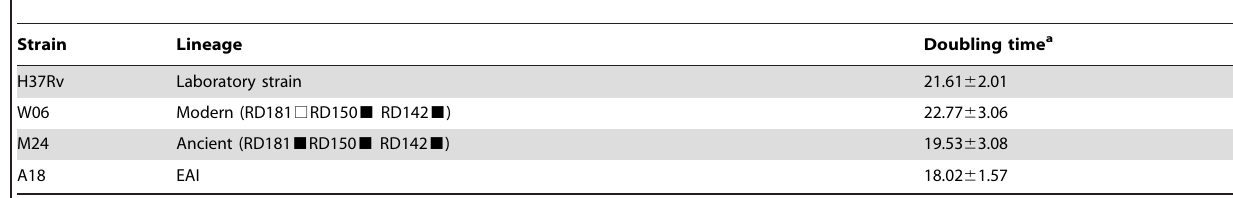
Table 2. Growth rate of different lineages of Mycobacterium tuberculosis